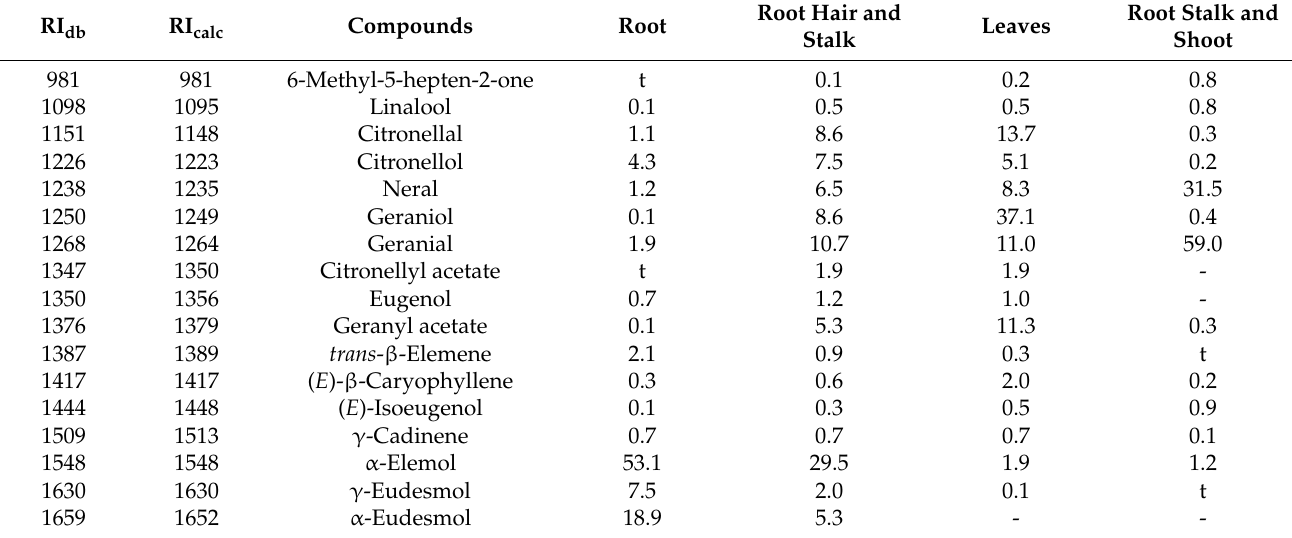
RI calc = Retention index determined with respect to homologous series of n-alkanes on a ZB-5 column. RI db = Retention index from the database [42,43]. “t” indicates trace ( ≤ 0.05%) and “-” indicates not detected. The leaves and root stalk and shoot oils largely contained monoterpenoids as